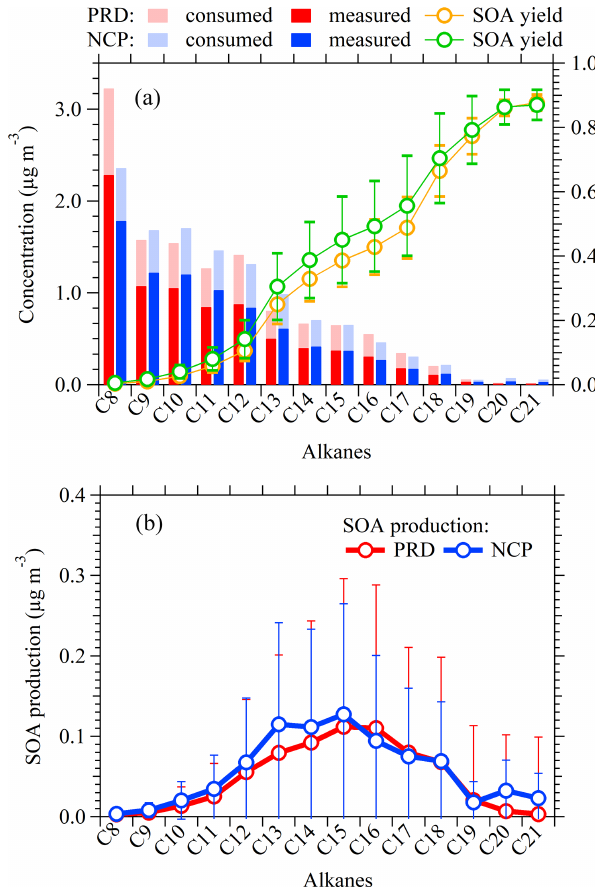
Figure 8. (a) Concentrations measured using NO + PTR-ToF-MS, calculated consumed concentrations, and average SOA yields for C8–C21 alkanes in PRD and NCP. The consumed concentrations represent the chemical losses of higher alkanes, which are calcu- lated by dividing the estimated SOA from each alkane by the cor- responding SOA yields. The error bars represent SDs (1 δ ) over the averaging period of calculated SOA yields. (b) Calculated average SOA productions for C8–C21 alkanes in PRD and NCP. The error bars represent SDs (1 δ ) over the averaging period of calculated SOA